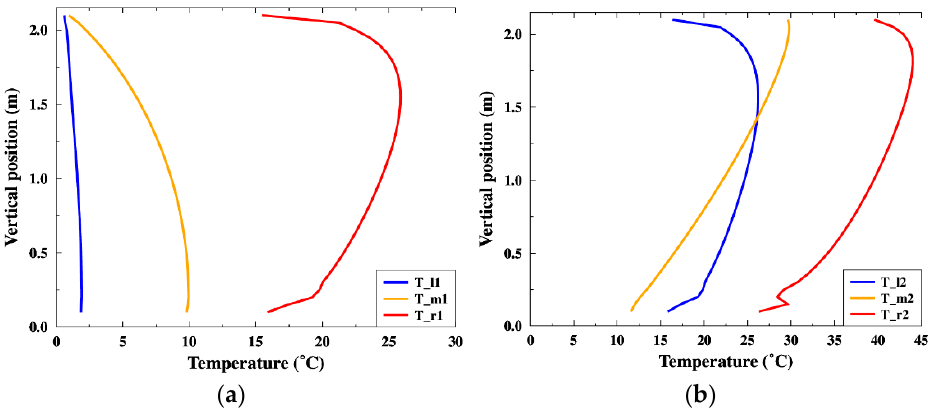
Figure 5. Temperature evolution of air and channel surfaces with VSW height: ( a ) outer air gap; ( b ) inner air gap. T_l and T_r represent the temperatures of the left and right surfaces of the air channel, respectively, and T_m represents the air bulk temperature.